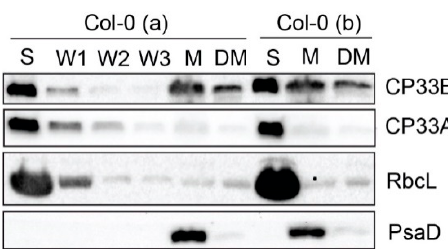
Figure 1. CP33B localizes to stroma and membrane fraction of chloroplasts. Chloroplasts of two wild type replicates (Col-0 a and b) were separated into stroma (S) and membranes (M). Membranes were washed 5 times. A membrane aliquot was treated with 0.5% sodium deoxycholate and the supernatant was harvested after treatment (DM). From each fraction, including the first three washing steps (W1, W2, W3) of Col-0 (a), equal volume fractions were separated electrophoretically by SDS PAGE and transferred to a nitrocellulose membrane. Besides the immunological detection of CP33A (antibody peptide a) and CP33B, antibodies for RbcL (large subunit of RuBisCO (ribulose 1.5 bisphosphate carboxylase / oxygenase)) and PsaD (subunit of photosystem I) served as stroma and membrane markers, respectively. The controls (RbcL, CP33A, PsaD) are reprinted with permission from Wiley; original Figure 2c in [8]; © 2020 John Wiley & Sons Ltd, Hoboken, New Jersey, USA.